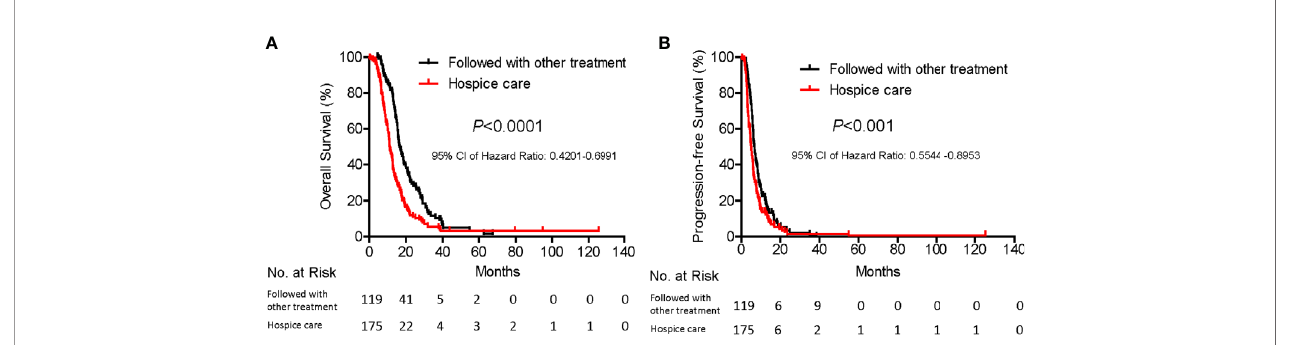
FIGURE 2 | Subgroup survival analysis of patients with and without curative treatment after SNCP- 125 I brachytherapy. Among 294 patients, 119 were followed with chemotherapy and immunotherapy and 175 patients with hospice care. Patients who were followed with other types of treatment showed signi fi cantly prolonged overall survival ( A , 16.5 months Vs. 11.2 months, p <0.0001) and progression-free survival ( B , 6.8 months Vs. 5.2 Months, p <0.001).